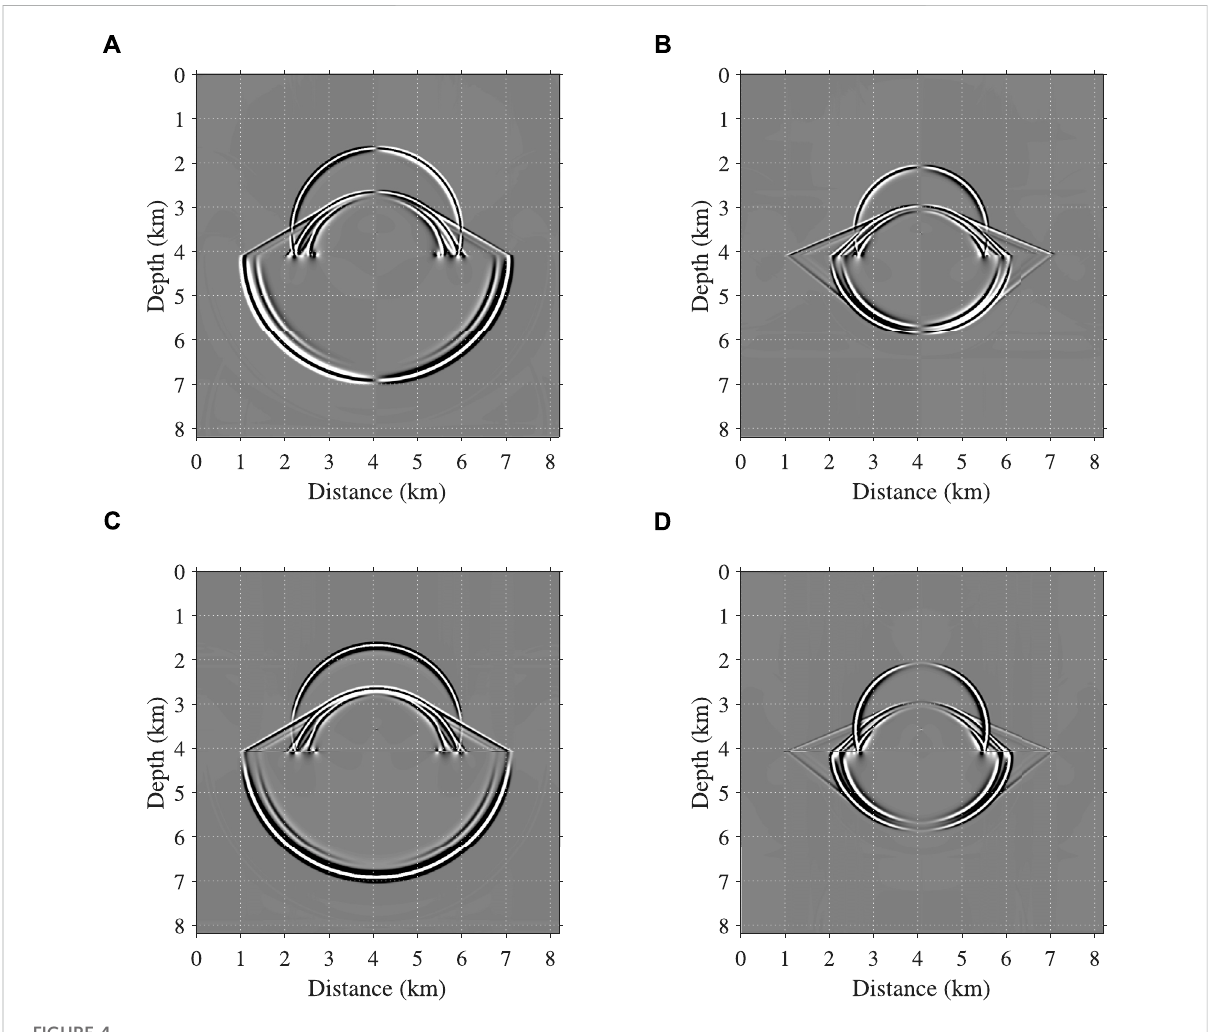
FIGURE 4 Wave mode decoupled snapshots of (A,B) v x and (C,D) v z , corresponding to the snapshots in Figures 3A,B. (A,C) show the decoupled P waves and (B,D) show the decoupled S